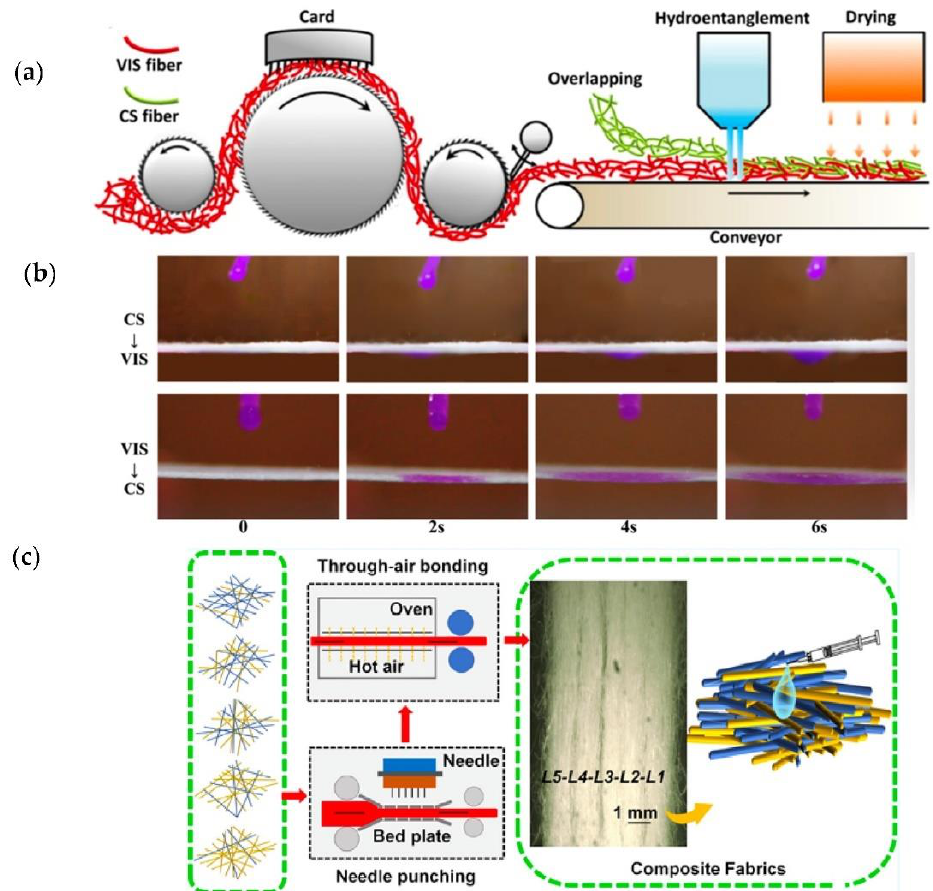
Figure 3. ( a ) Schematic illustration of the fabrication of the CS/VIS composite nonwoven fabric; ( b ) water-penetration phenomenon from both sides of the composite [34] (Copyright 2019, American Chemical Society). ( c ) Schematic illustration of the fabrication of composite fabrics via the combination of needle punching and through-air bonding process [27] (Copyright 2021, American Chemical